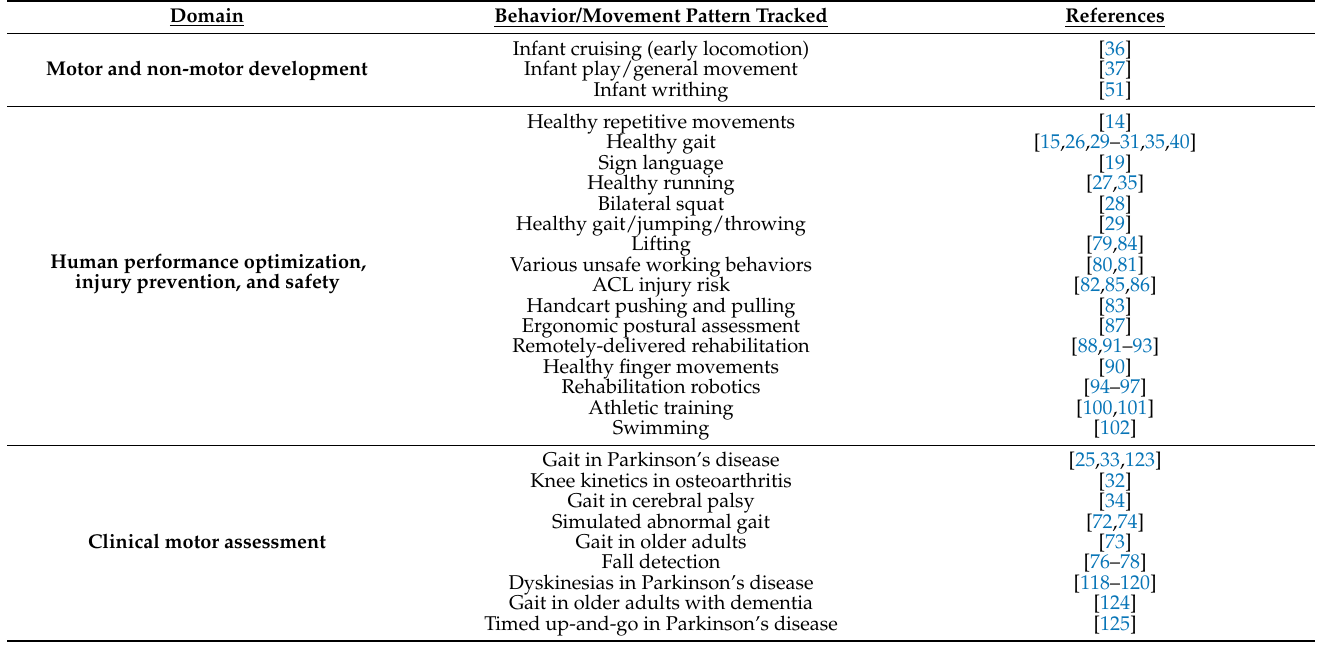
Table 1. Summary of example applications of pose estimation in human health and performance across the lifespan.